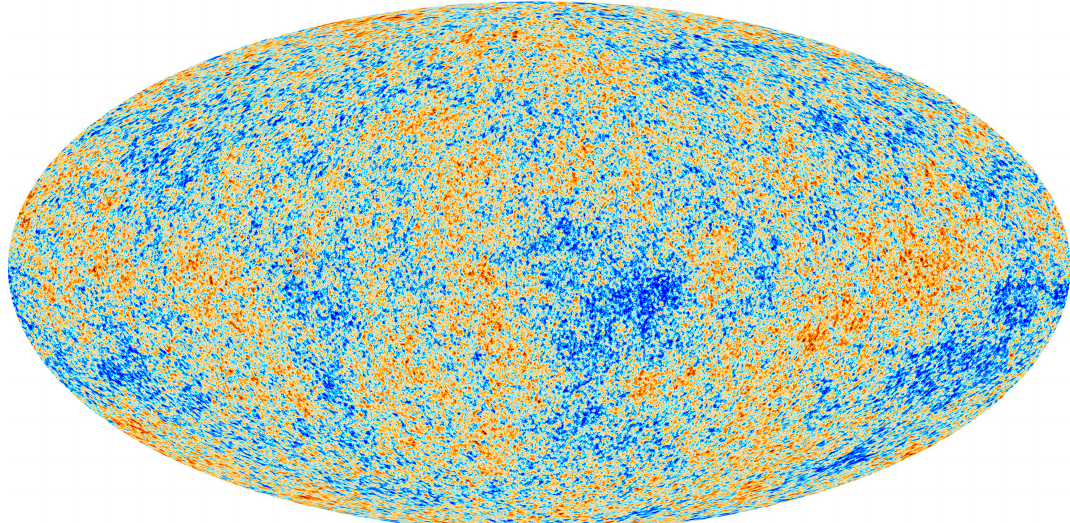
Figure 6. The Cosmic microwave background (CMB) anisotropies as observed by Planck. The CMB is a snapshot of the oldest light in our Universe, imprinted on the sky when the Universe was just 370 to 380 thousand years old. It shows tiny temperature fluctuations that correspond to regions of slightly different densities, representing the seeds of all future structure: the stars and galaxies we see today. Science and Exploration, Planck CMB. Copyright ESA and the Planck